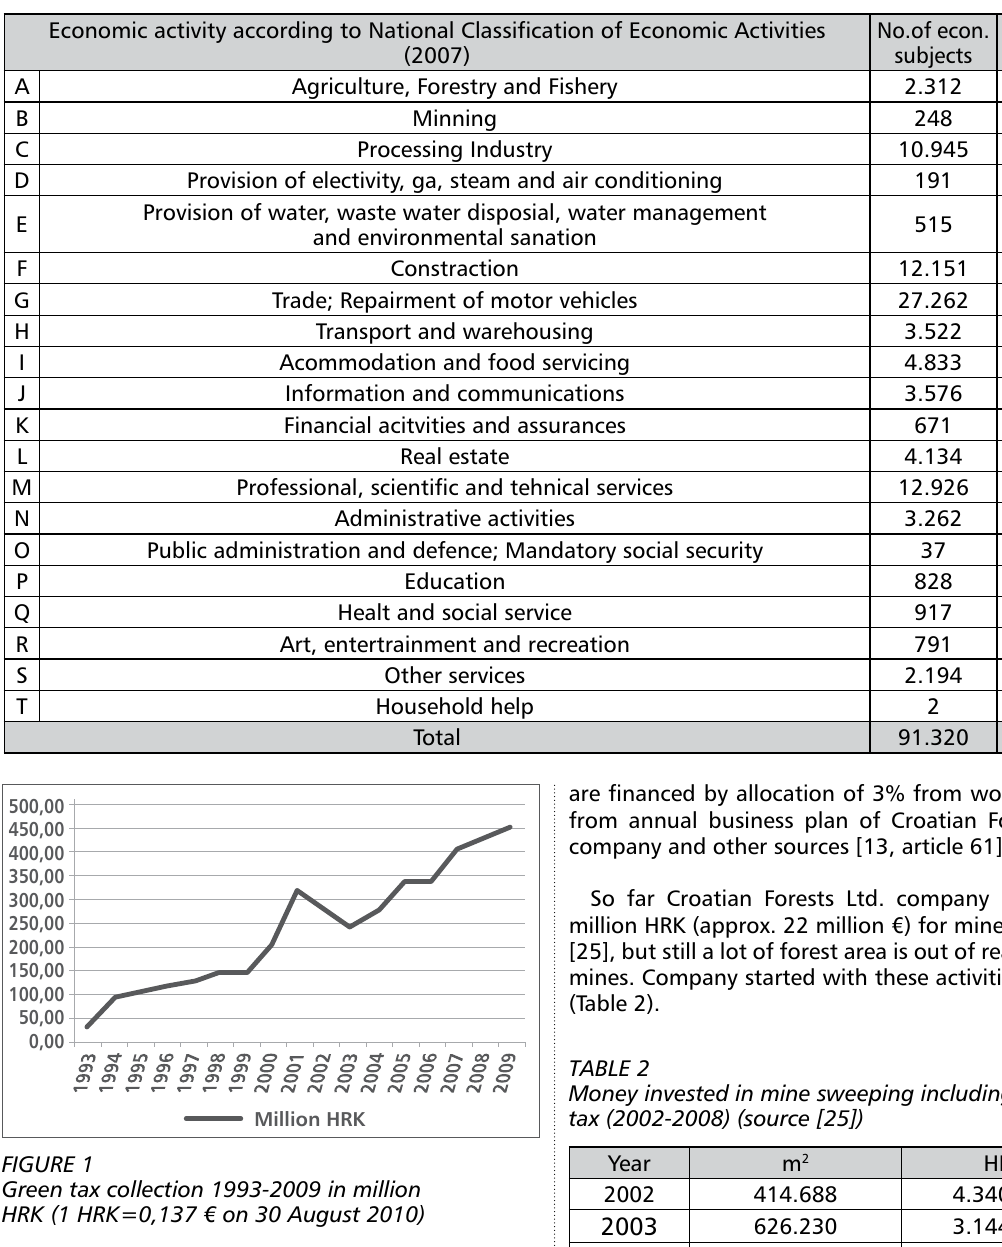
Share of green tax in 2009 according to economics activities (based on National Classification of Economic Activities, OG 58/2007) (source: Croatian Forests Ltd.)